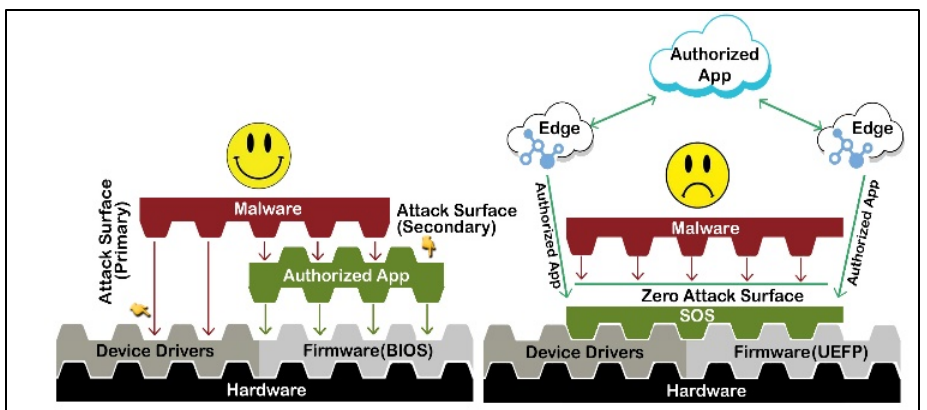
Figure 5. Comparison of architectural constructs of 3rd party permissions and attack surface between legacy IoT systems and ZVC .